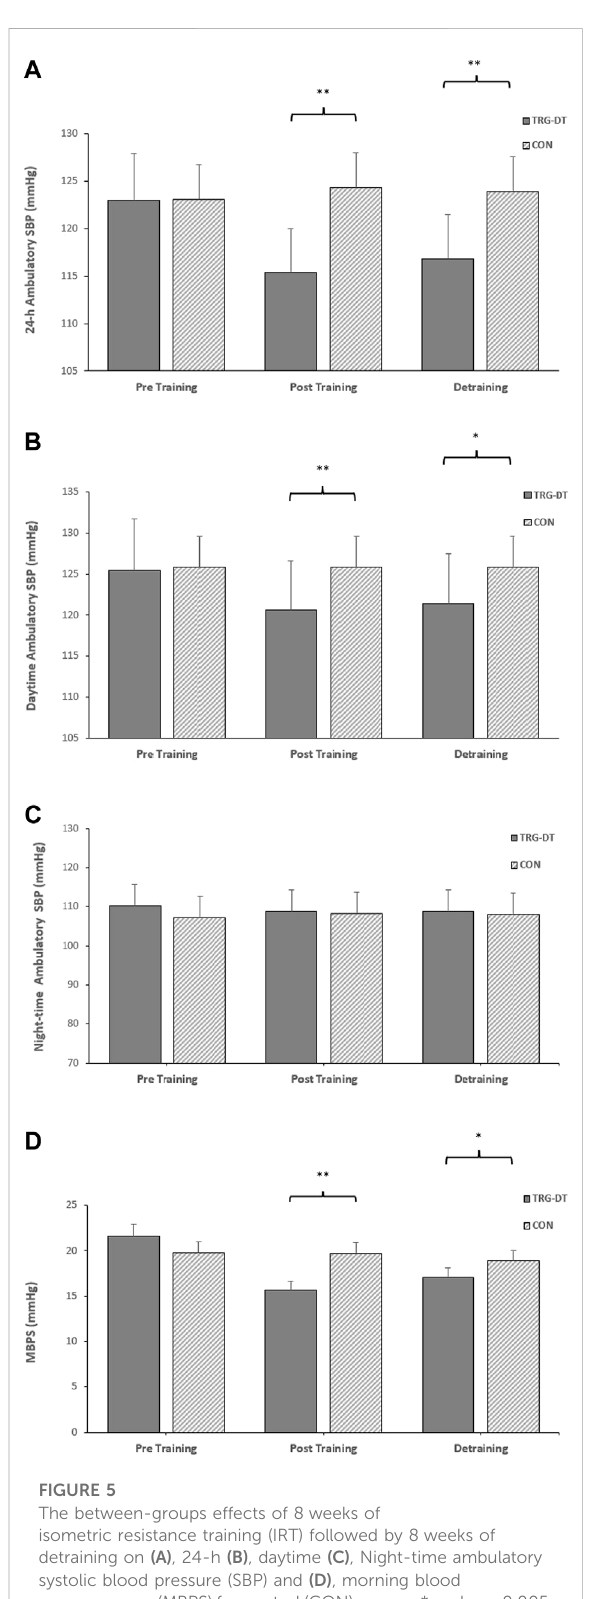
FIGURE 5 The between-groups effects of 8 weeks of isometric resistance training (IRT) followed by 8 weeks of detraining on (A) , 24-h (B) , daytime (C) , Night-time ambulatory systolic blood pressure (SBP) and (D) , morning blood pressure surge (MBPS) for control (CON) groups. * p value < 0.005, ** p value <